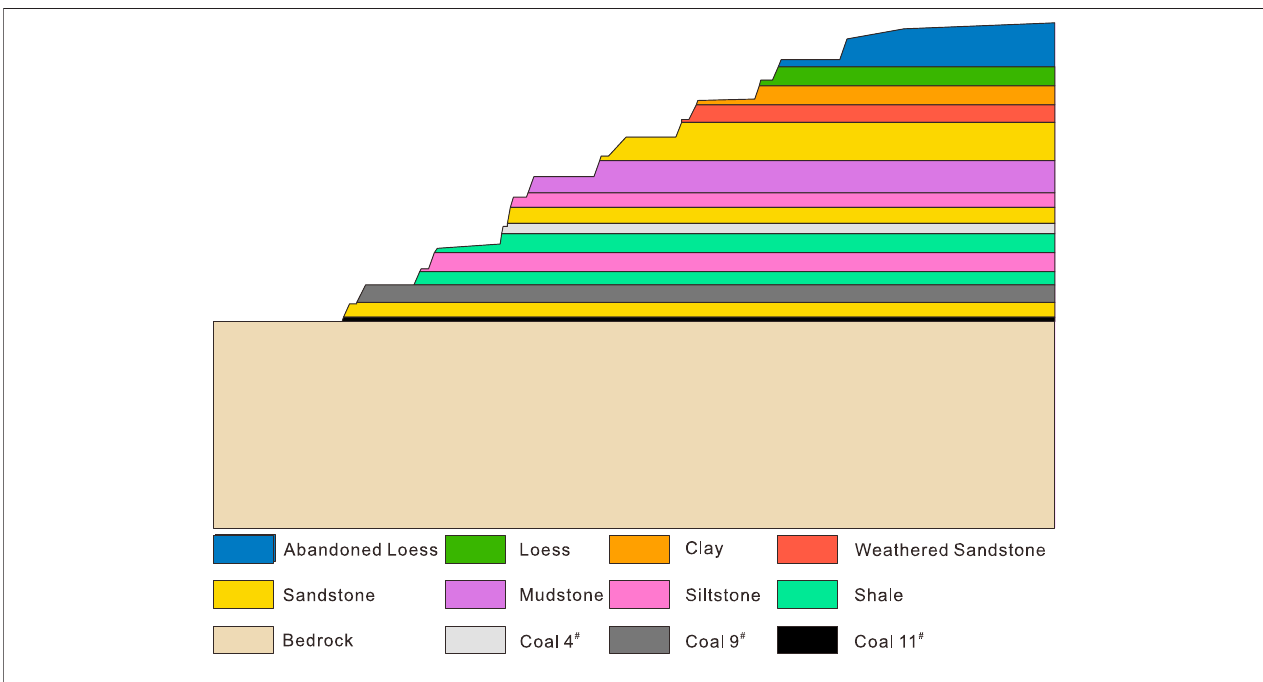
FIGURE 6 | Distribution map of rock strata in the Antaibao open-pit mine.